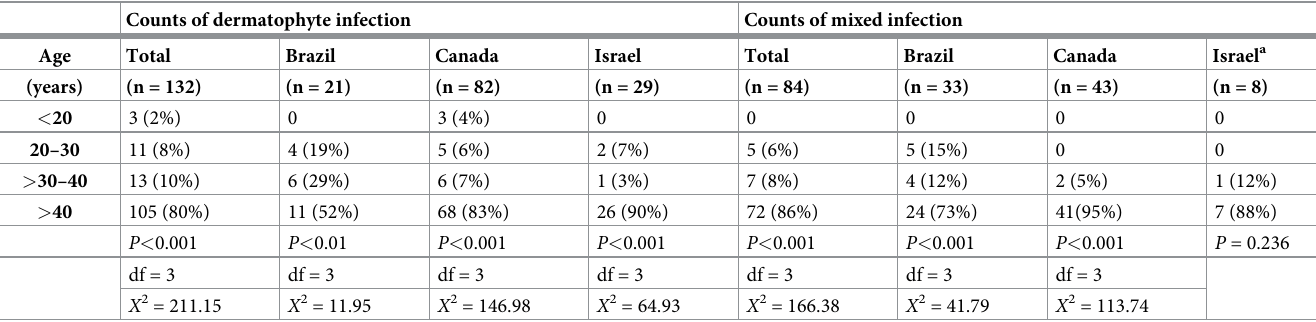
Table 3. Onychomycosis infection type by country and age.